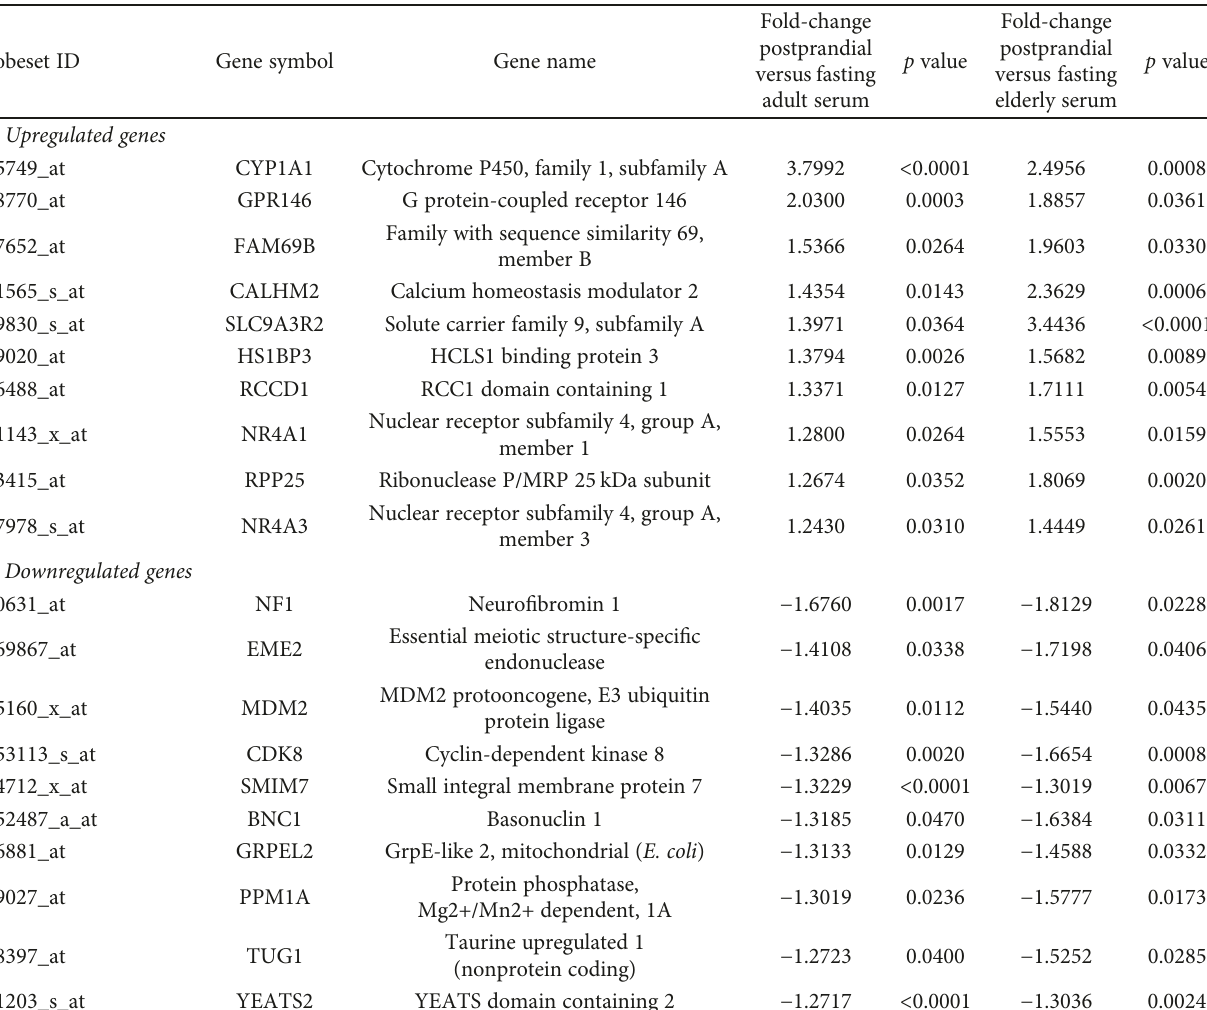
Table 2: Representative genes with greatest fold di ff erences in HCAEC exposed to fasting or postprandial ∗ serum from adult and elderly